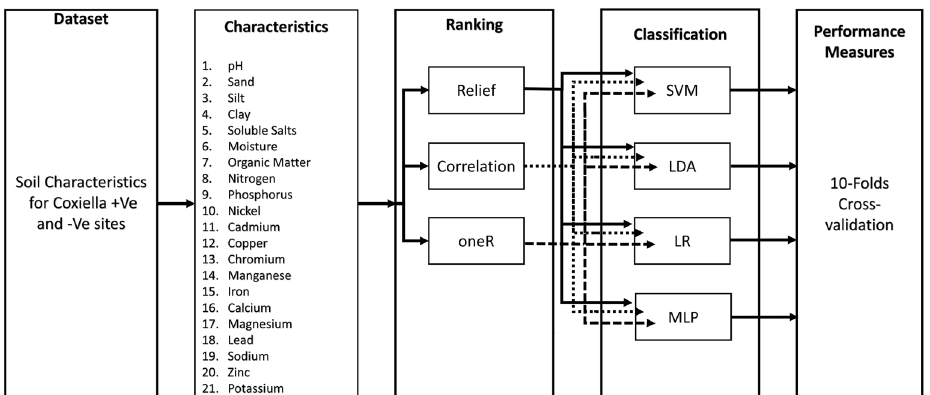
Figure 1. Various phases of Coxiella classification in Soil attribute dataset.